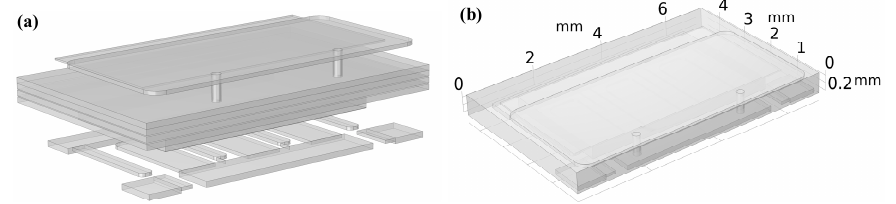
Figure 3. Exploded view of COMSOL simulation model ( a ) and top view of simulation model ( b ). Table 1. Model dimension, location and material.